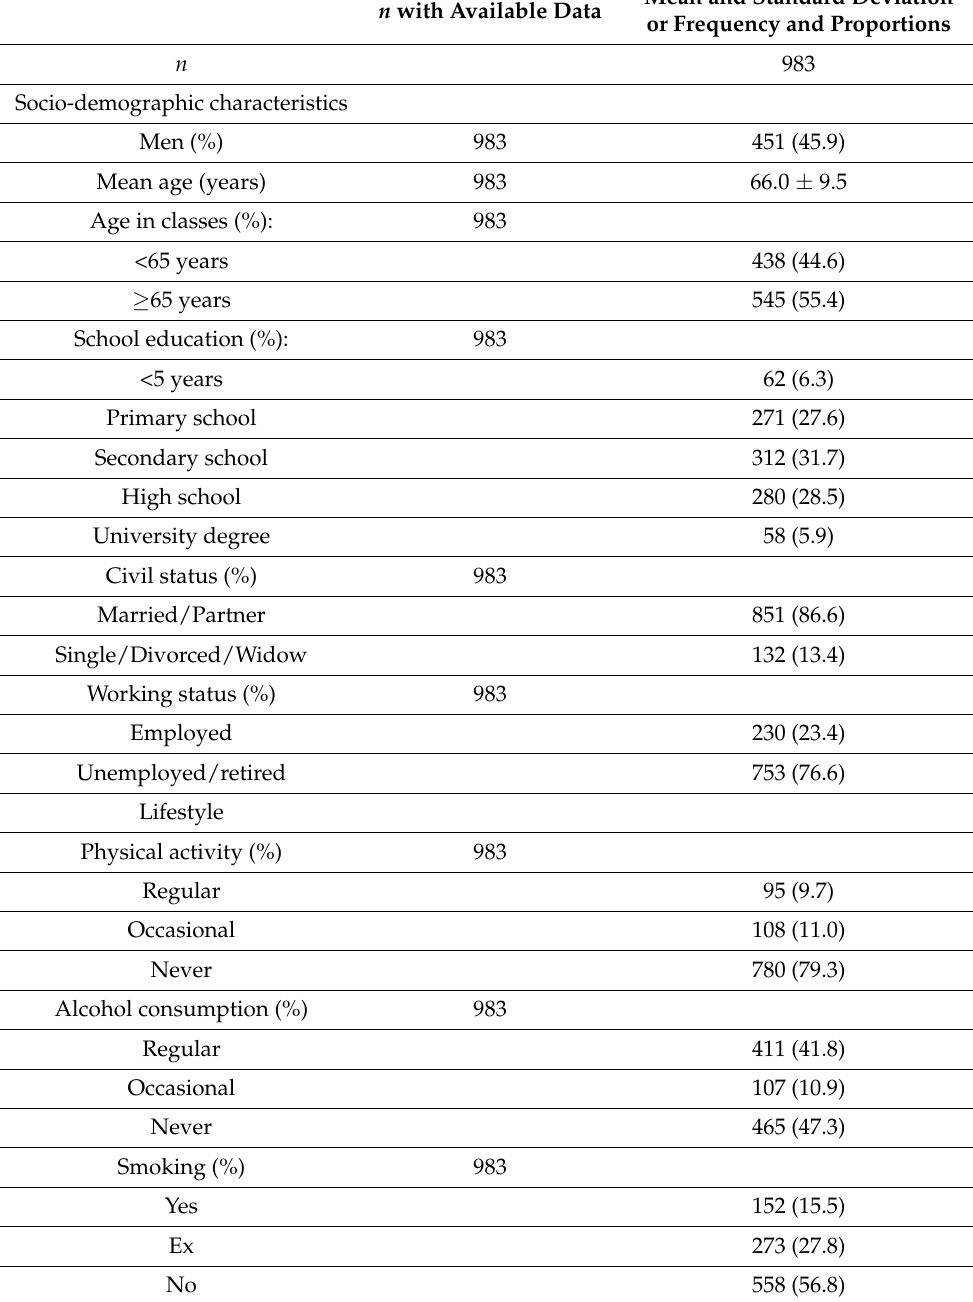
Table 1. Characteristics of the study